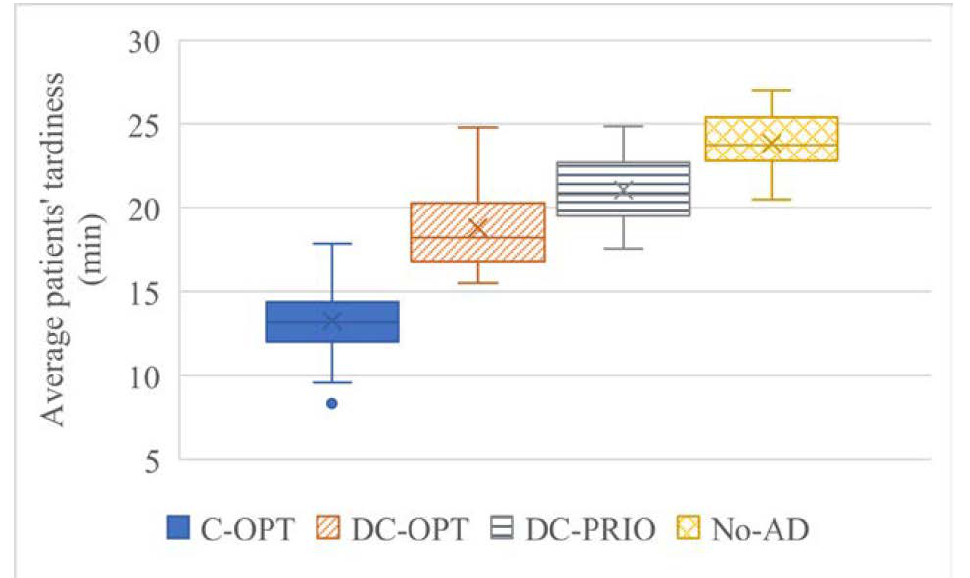
Figure 4. Box plot of average tardiness of patients.